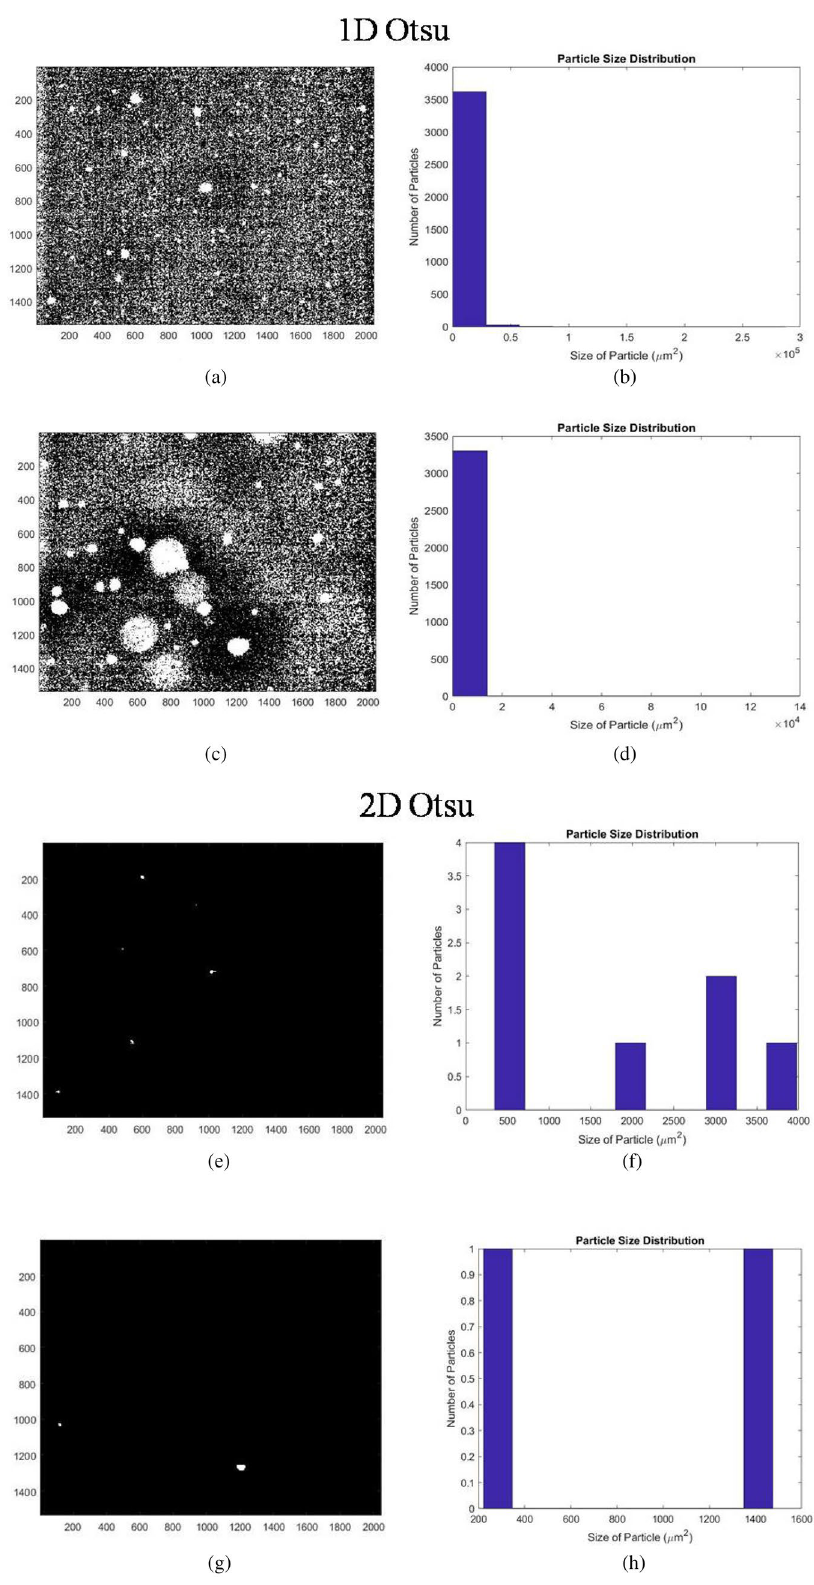
Figure 7. Output of 1D and 2D Otsu thresholding. ( a ) and ( b ) are the 1D Otsu thresholded output figure and size distribution graph of Fig. 4b. ( c ) and ( d ) are the output for Fig. 4c. ( e ) and ( f ) are 2D Otsu thresholded output figure and size distribution graph of Fig. 4b. ( g ) and ( h ) are the 2D Otsu thresholded output figure and size distribution graph of Fig.